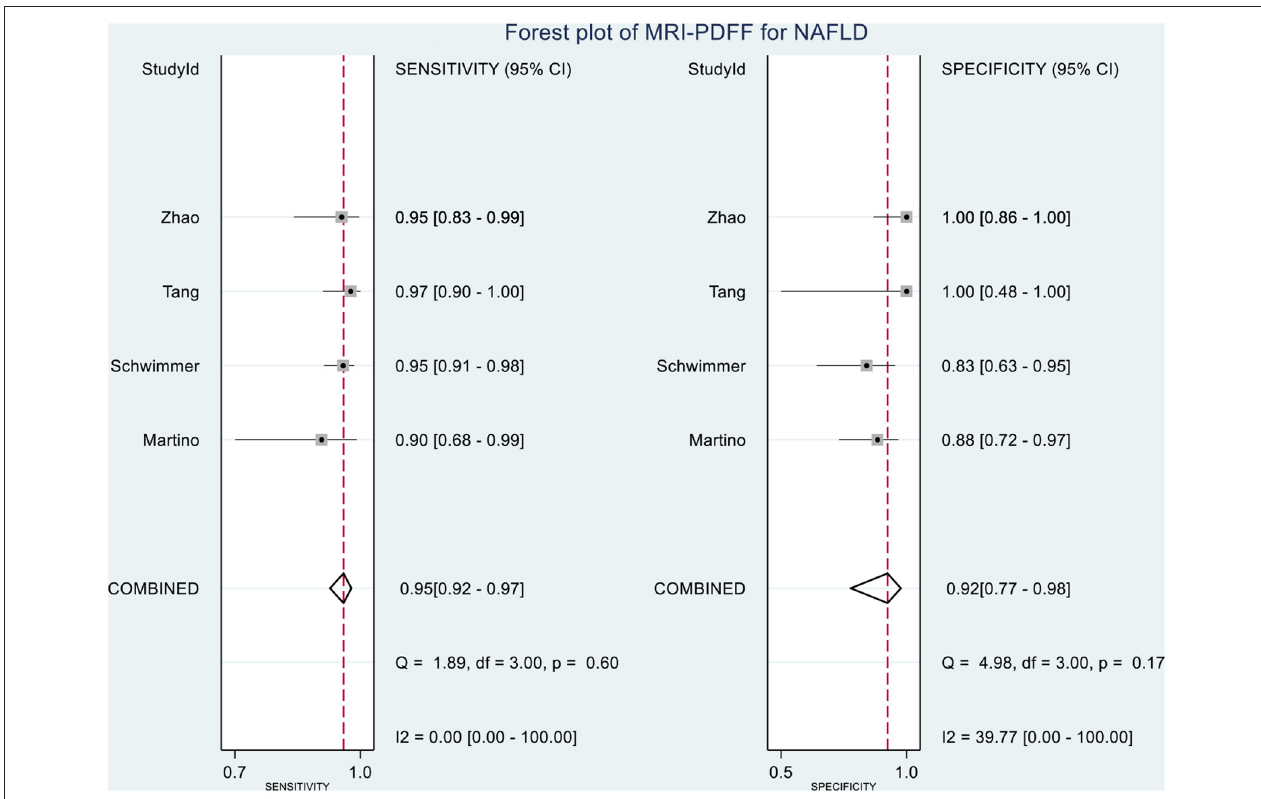
FIGURE 8 | Forest plot to evaluate the sensitivity and specificity of MRI-PDFF in diagnosing NAFLD (S0 vs.